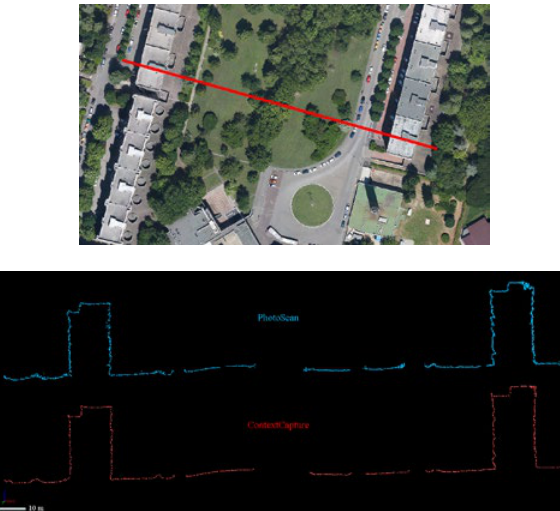
Figure 6. Section of the two point clouds. Top: the section plane, bottom: the obtained result (red: ContextCapture, blue: PhotoScan Pro).